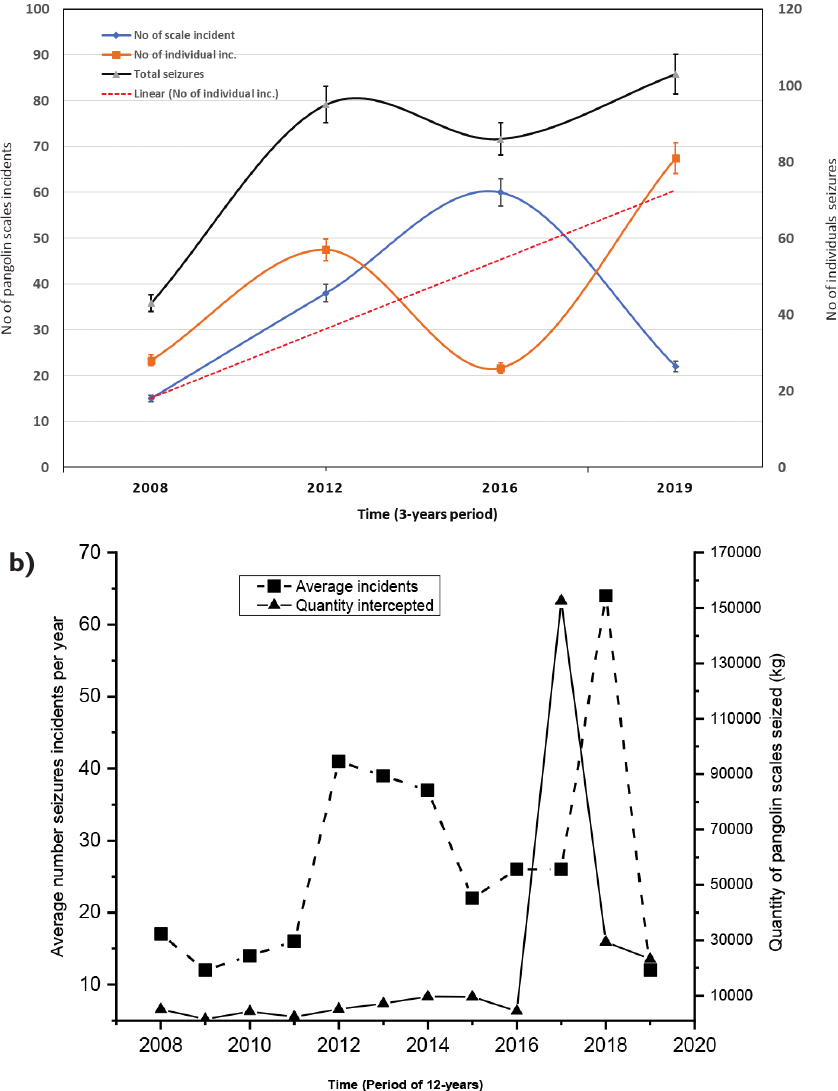
Figure 1. Plot of the mean number of scales seizures incidents (Blue); and mean number of individual pangolins seized (Brown square); the plot of linear (Dot-redline) shift in pangolin incidents per 3 years from January 2008 to December 2019 ( a ), and ( b ) the plot number of average seizures incidents (squares) and quantity of pangolin scales seized (triangles) in